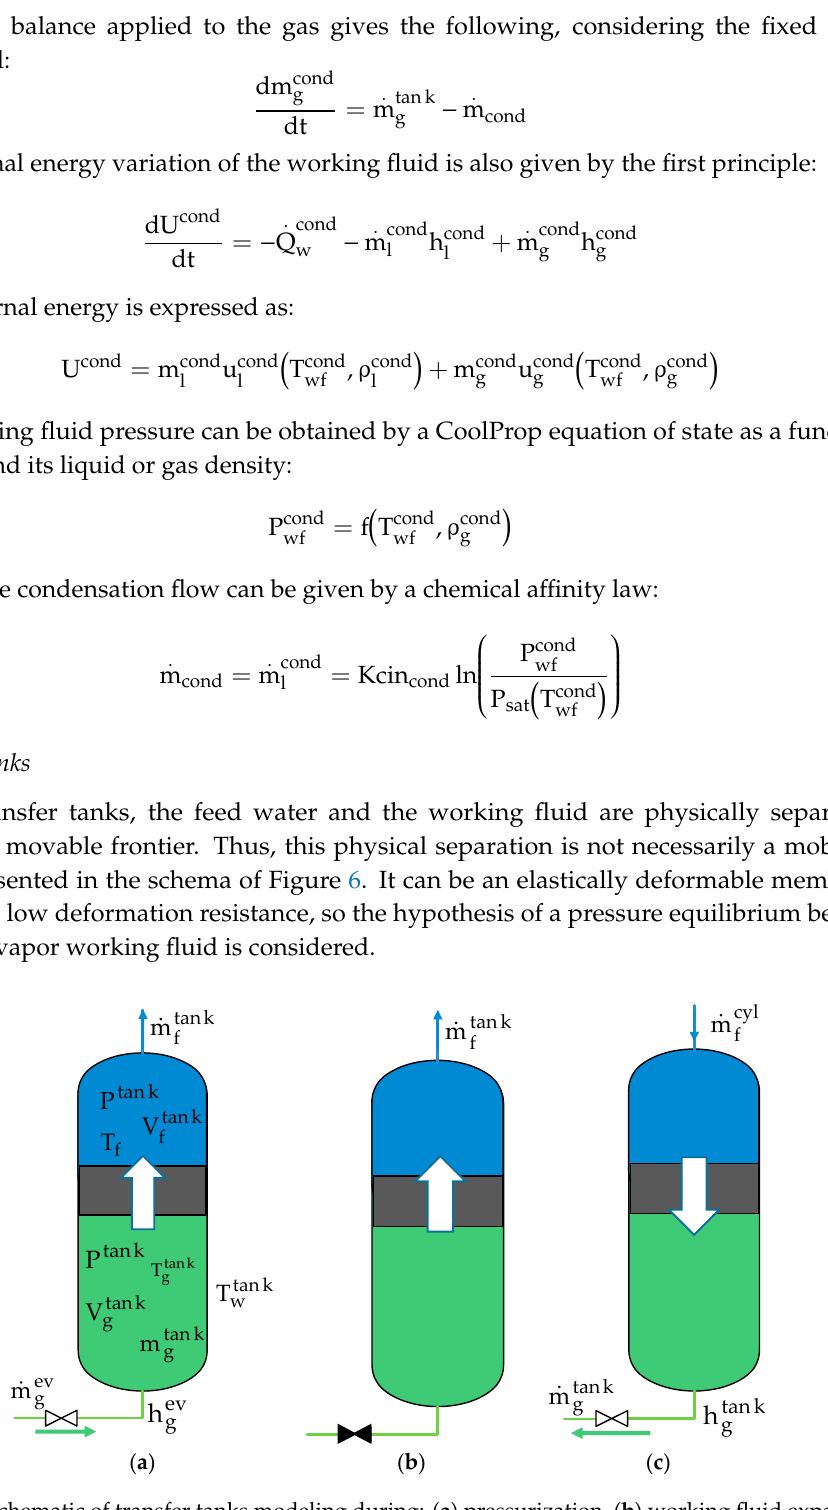
Figure 6. Schematic of transfer tanks modeling during: ( a ) pressurization, ( b ) working fluid expansion, and ( c ) water